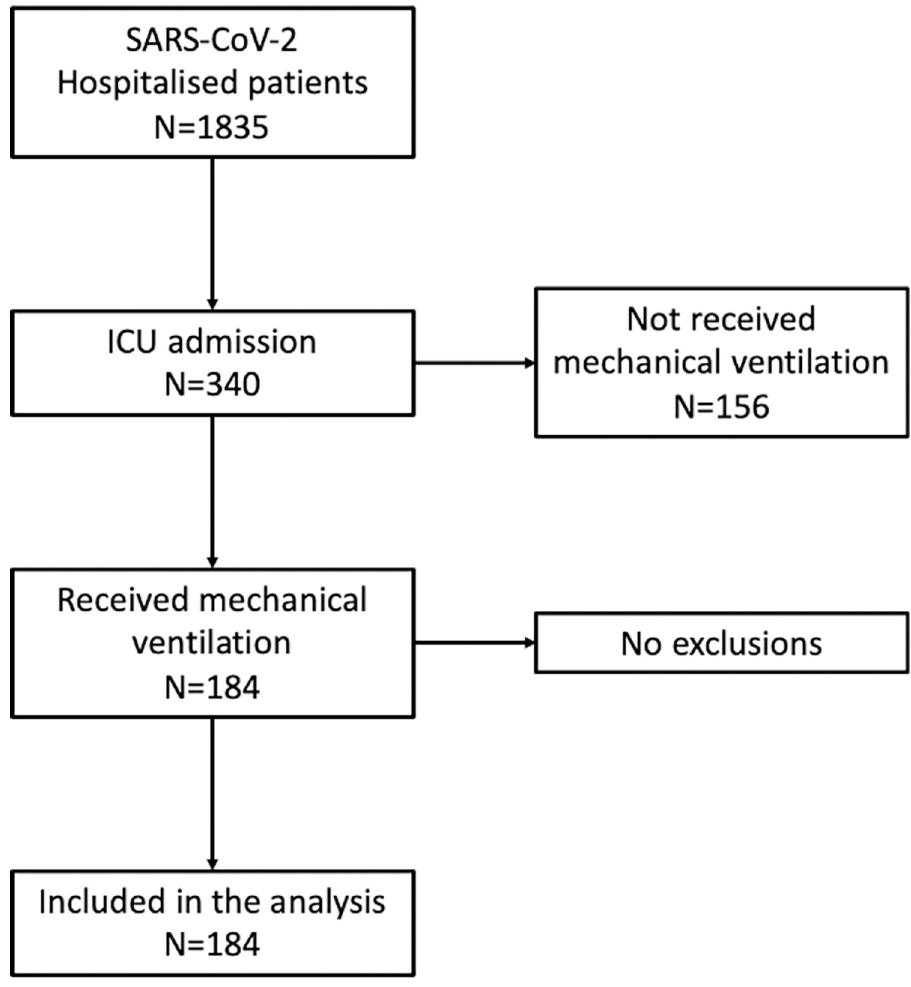
Fig 1. Flow diagram of included participants. The median age was 59.5 years (IQR 51.0, 67.0), and survivors were significantly younger, 57.0 (IQR 49.0, 64.0) compared to non-survivors, 65.0 (IQR 59.5, 72.0) with male predomi- nance (62.5%). Gender was not associated with increased mortality. 129 patients were of white ethnic origin (70.1%), and 55 were from ethnic minority groups (29.9%). The median body mass index (BMI) was 30.0 (IQR 25.8, 35.5), with no significant difference between survivors, 30.1 (IQR 25.2, 35.8) and non-survivors 29.4 (IQR 26.6, 33.8). The median admission Acute Physiology and Chronic Health Evaluation II (APACHE II) score was 18 (IQR 12, 23) giving a predictive mortality of 25%. Survivors had a significantly lower score, 16.0 (IQR 11.0, 23.0) compared to non-survivors, 19.0 (IQR 14.3, 24.8) both of which also fall into the 25% expected mortality prediction. The median Sequential Organ Failure Assessment (SOFA) score on admission was 4.0 (IQR 3.0, 7.0) giving a predictive mortality of 36.1%. There was no signifi- cant difference in the SOFA score between survivors, 4.0 (IQR 3.0, 6.0) and non-survivors, 5.5 (IQR 4.0, 8.0). The median Clinical Frailty Score (CFS) was 2.0 (IQR 2.0, 3.0) meaning ‘well’, with no significant difference between survivors, 2.0 (IQR 2.0, 3.0) and non-survivors, 2.0 (IQR 2.0, 4.0). Median Charlson Comorbidity Index (CCI) was 2.0 (IQR 1.0, 3.0), with